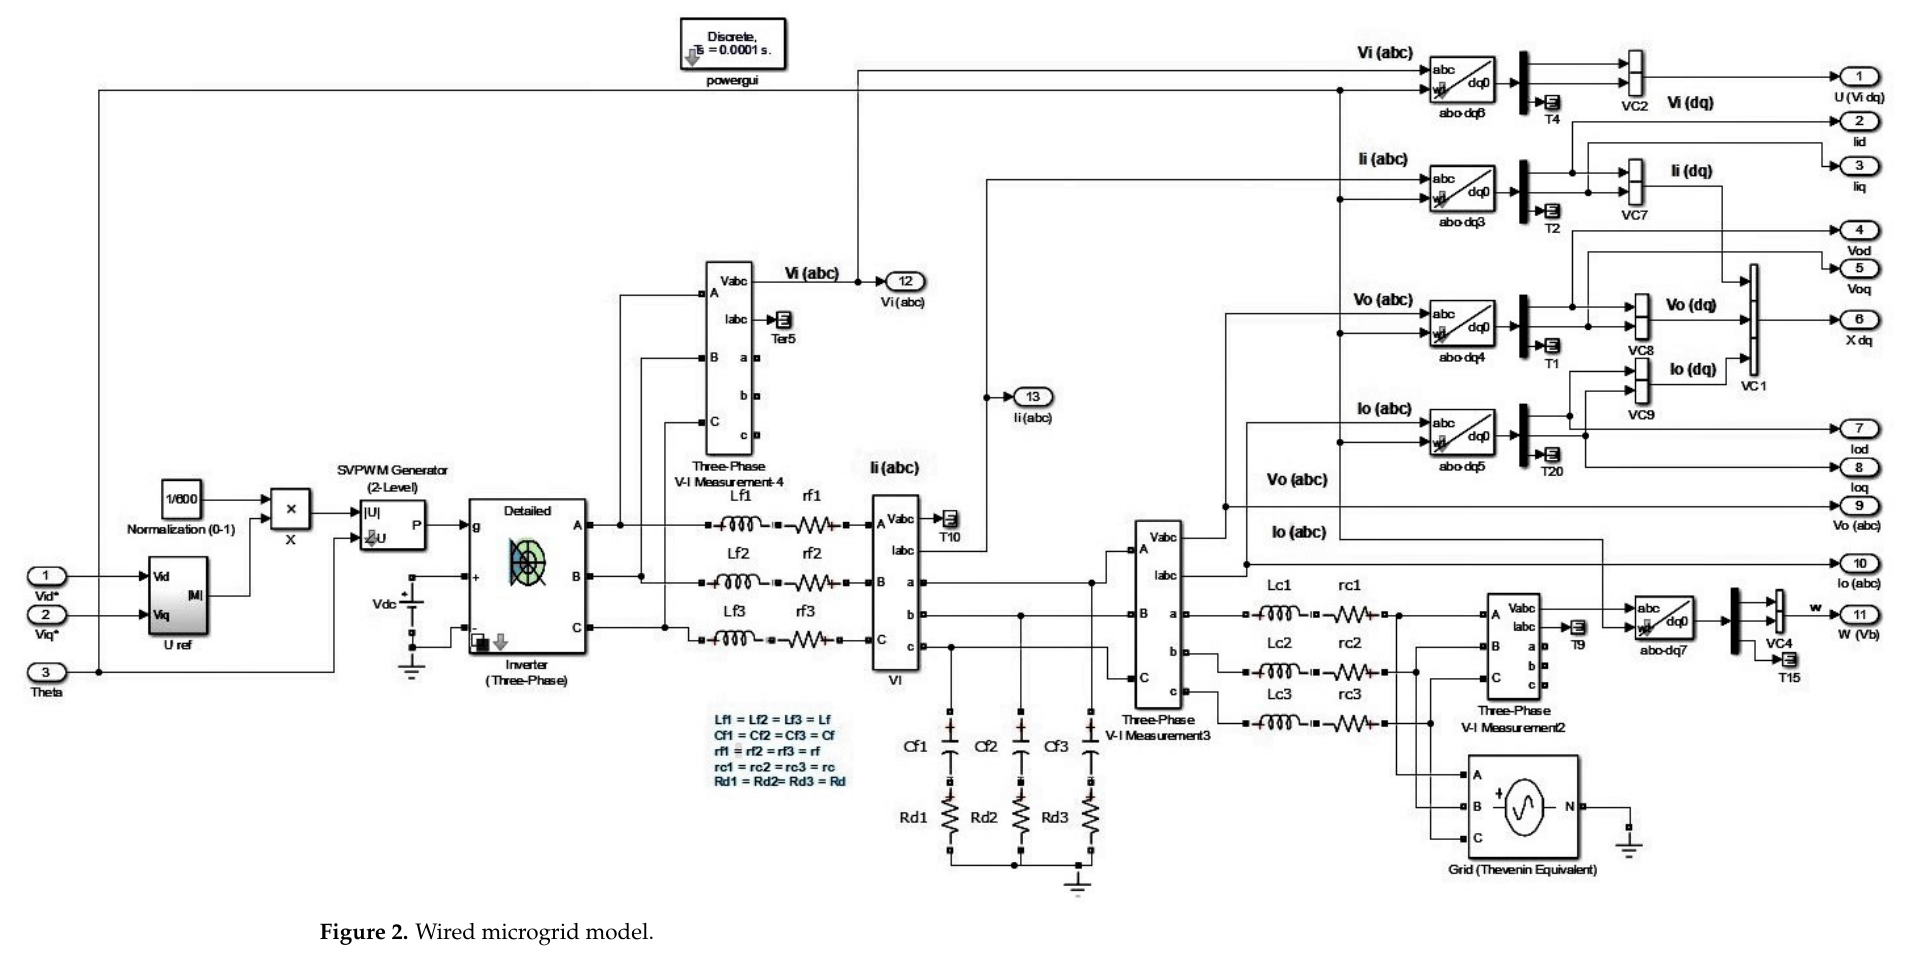
Figure 2. Wired microgrid